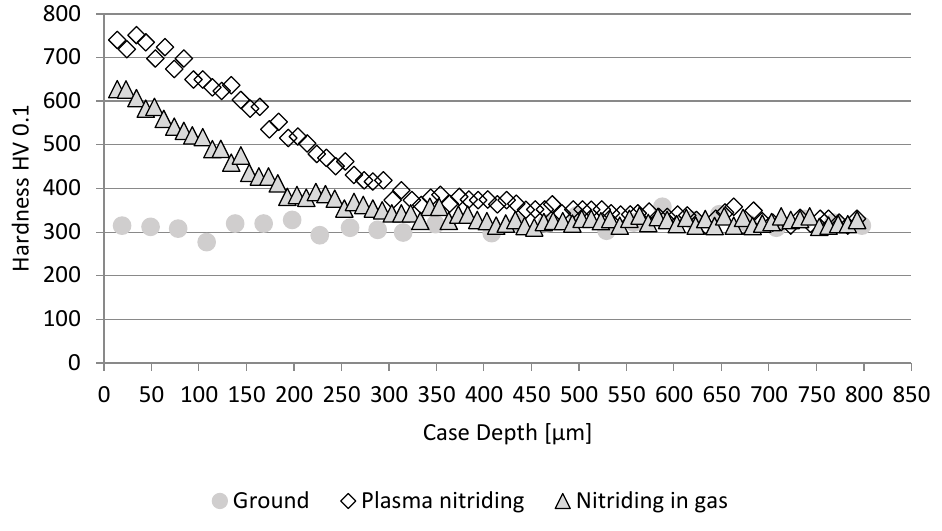
Figure 3. Microhardness profiles of samples nitrided in plasma and in gas.